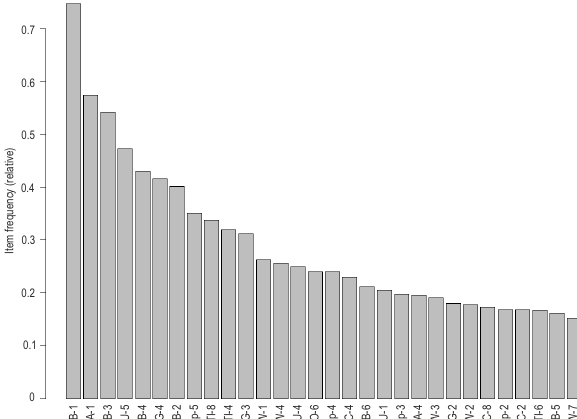
Figure 4. Attributes whose frequency was higher than 0.15